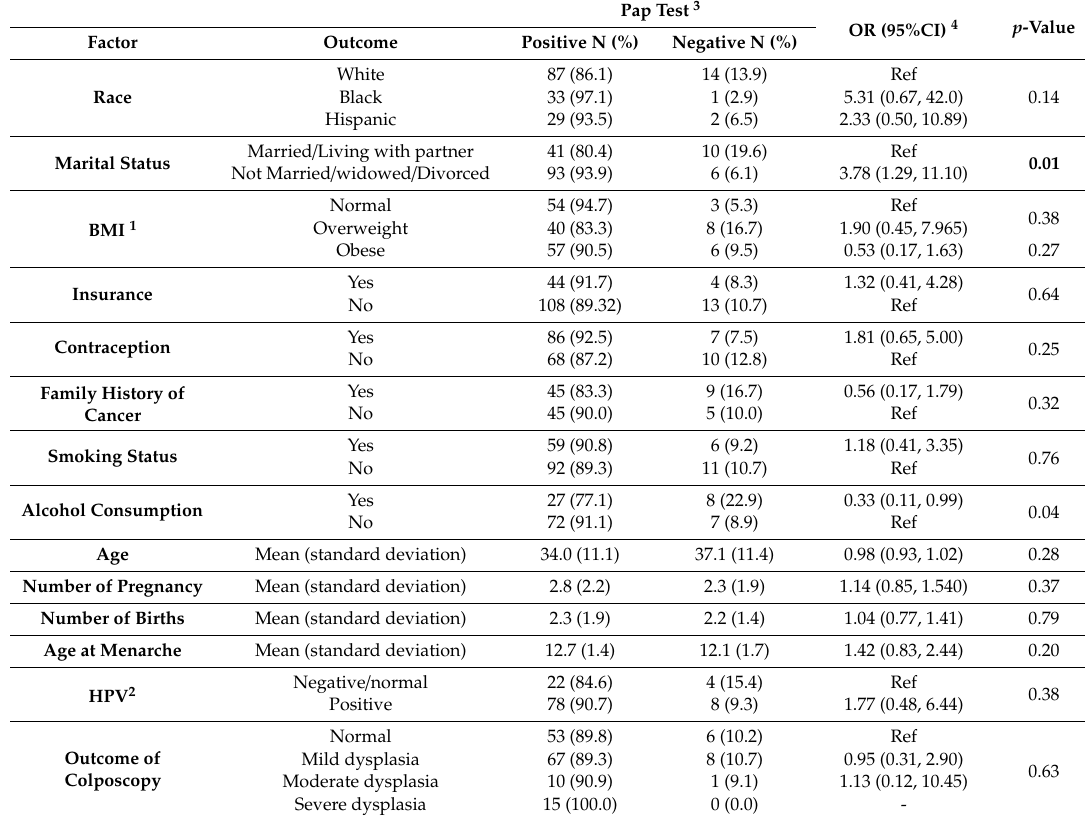
Association between outcome from the Pap test and colposcopy, HPV status and socio-demographic